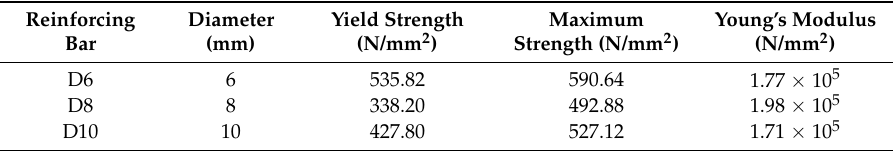
Table 4. Mechanical properties of reinforcing